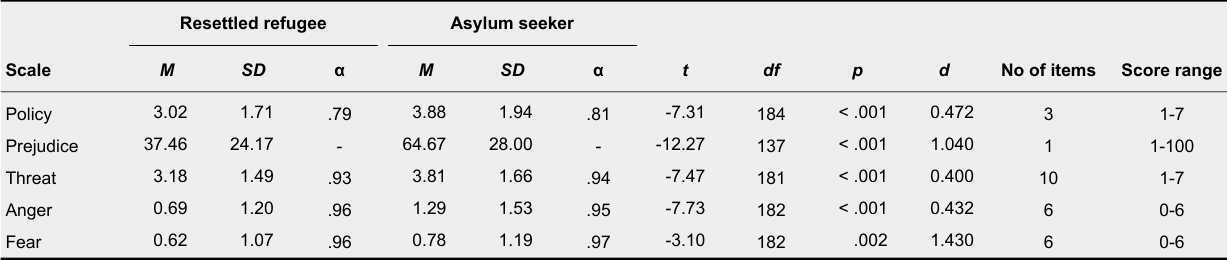
Descriptive Characteristics of Scales